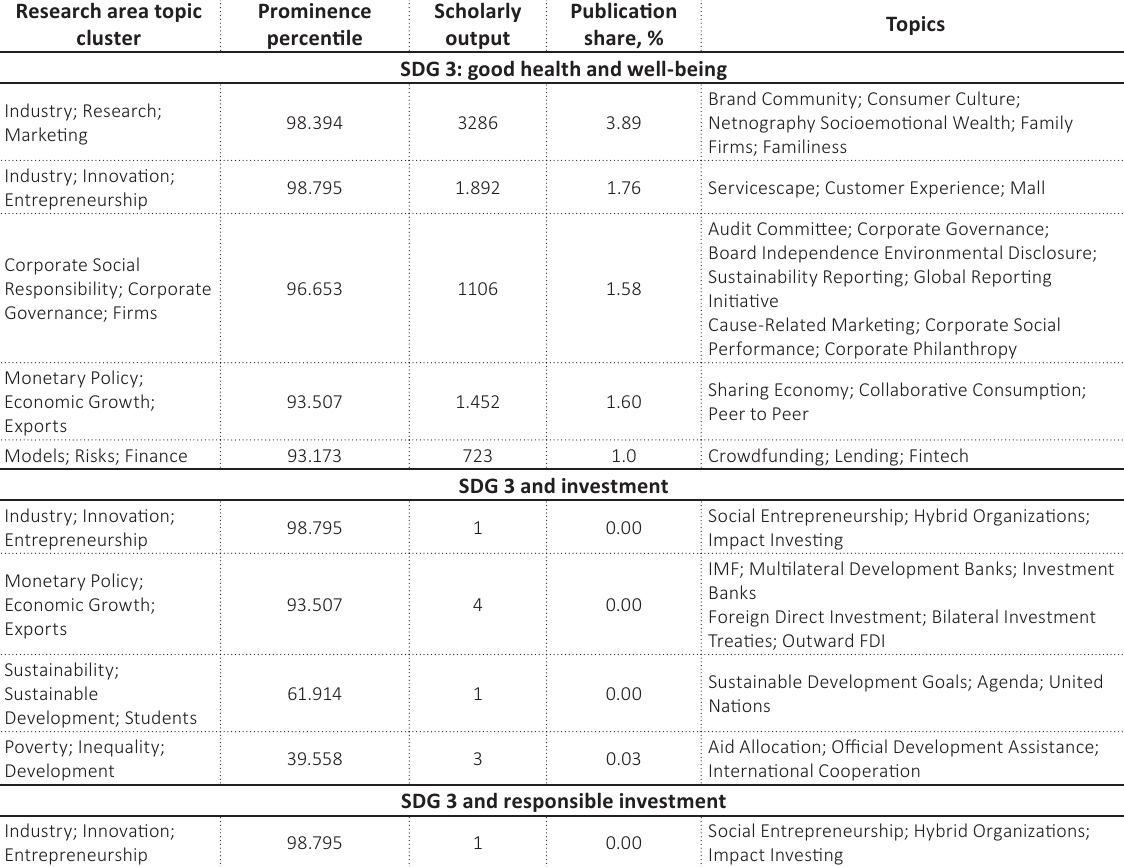
Table 4. Economic topics and topic clusters in each research area during 2010–2019 by prominence